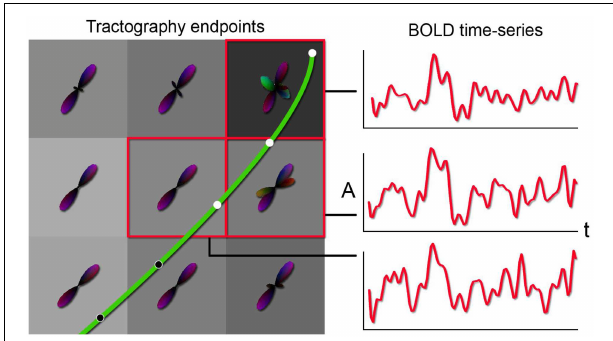
FIGURE 2 | Principle behind the new tractography-driven rs-fMRI correlation method. When a streamline reaches the gray matter (left), its propagation is stopped. By looking at the BOLD signals within the voxels encompassed by the last n points (3 in this case) of the streamline, the average of the signals is correlated with all other voxels of the brain